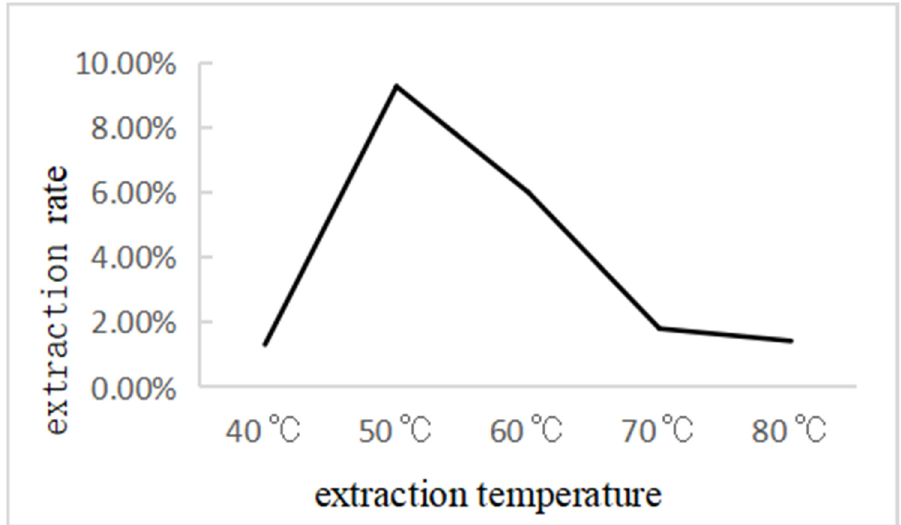
Figure 3. Effect of extraction temperature on the extraction yield of coumarins.